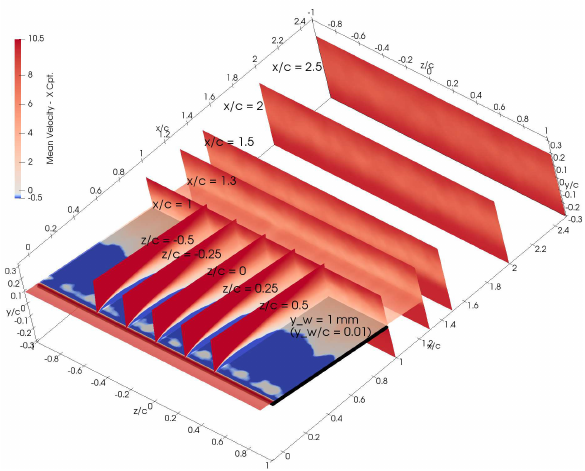
Fig. 3 . Sampling planes annotated, mean velocity streamwise component plotted. Plate surface rendered